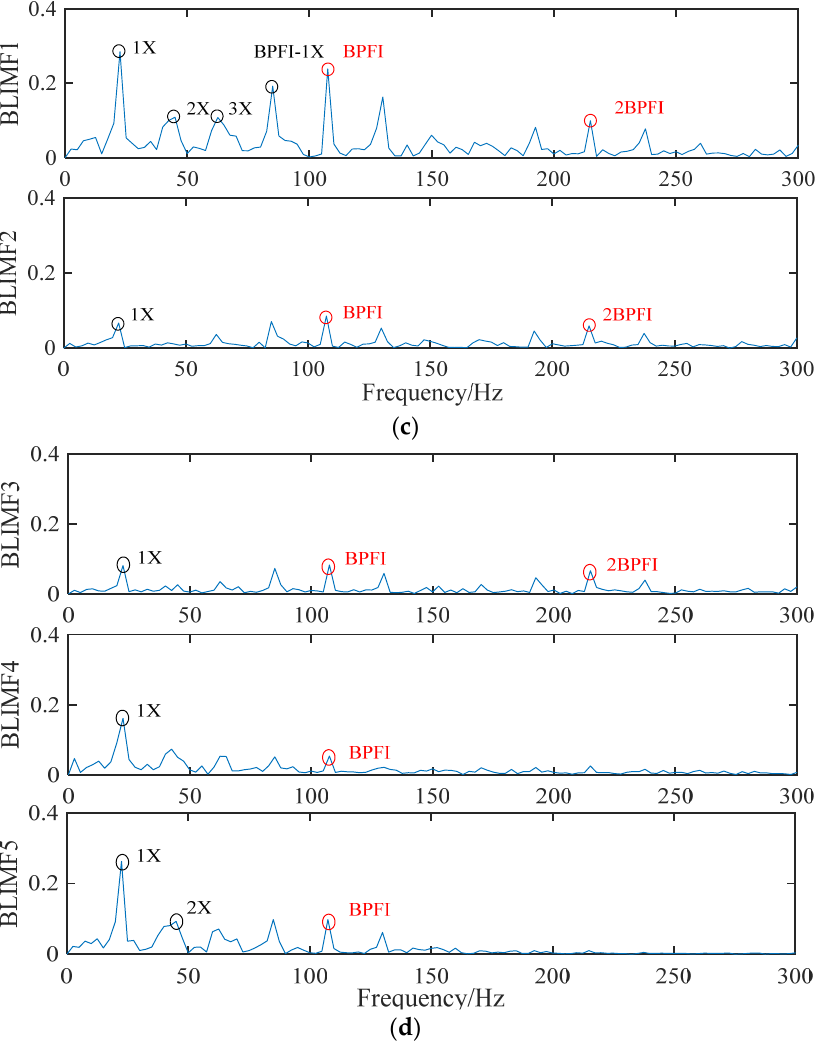
Figure 9. Envelope spectrum: ( a ) CEEMDAN, ( b ) EWT, ( c ) VMD, and ( d ) VMD with unoptimized parameters.